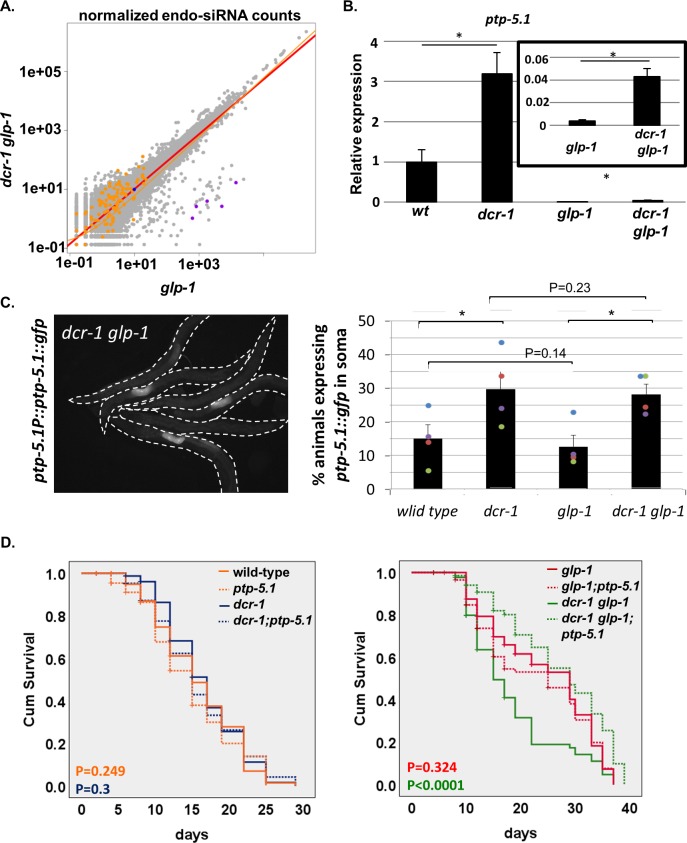
Inactivation of ptp-5.1 restores longevity in GSC(-) animals with perturbed endogenous siRNA.(A) Scatter plot depicts comparisons of gene-by-gene siRNA counts from three paired glp-1 mutant and dcr-1 glp-1 double mutant samples. Gray- all genes. Orange- 132 genes whose levels increased by more than 1.5 folds in dcr-1 glp-1 double mutants compared to glp-1 single mutants at the transcriptome analysis. Purple- five overlapping genes between the transcriptome analysis and siRNA seq, which are candidate direct targets of endo-siRNA. Blue- ptp-5.1 (c24d10.1). See also Figure 4—figure supplement 1 and Supplementary files 4, 5, 6, and 7. (B) qRT-PCR of ptp-5.1 transcript on day 1 of adulthood. Asterisks mark Student’s t-test values of p value<0.05 of 4 independent experiments. Data are presented as mean ± SEM. The low levels of ptp-5.1 transcript in GSC(-) animals is consistent with the interpretation that in GSC(+) animals, most of the transcript is expressed in the germline. (C) Representative fluorescent images of dcr-1 glp-1 transgenic animals expressing an extrachromosomal array of a translational reporter fused to the ptp-5.1 gene, driven by ptp-5.1 upstream sequences. Note that the reporter is only detected in a fraction of the animals. Animals that expressed the reporter displayed a clear fluorescent signal specifically in two adjacent cells in the mid-intestine (see Figure 4—figure supplement 2B). A similar expression pattern of the transgene was observed in all genetic backgrounds (see Figure 4—figure supplement 2). Bars represent mean of the percentage of animals expressing the ptp-5.1::gfp transgene in the intestine. At least 250 animals per strain were scored in four independent experiments. Different colors represent independent experiments. Cochran-Mantel-Haenszel test P-values are indicated. Asterisks mark p<0.001. Somatic expression of the transgene was detected in all backgrounds in a fraction of the animals. Inactivation of the endo-siRNA pathway by the dcr-1 mutation increased the fraction of the animals expressing the reporter in their mid-intestine. (D) ptp-5.1(tm6122) extended the lifespan of dcr-1 glp-1 double mutants. Breslow (Generalized Wilcoxon) P-values for each mutant vs. the mutant; ptp-5.1(tm6122) double mutant are indicated. See Supplementary file 1 for additional lifespan data.